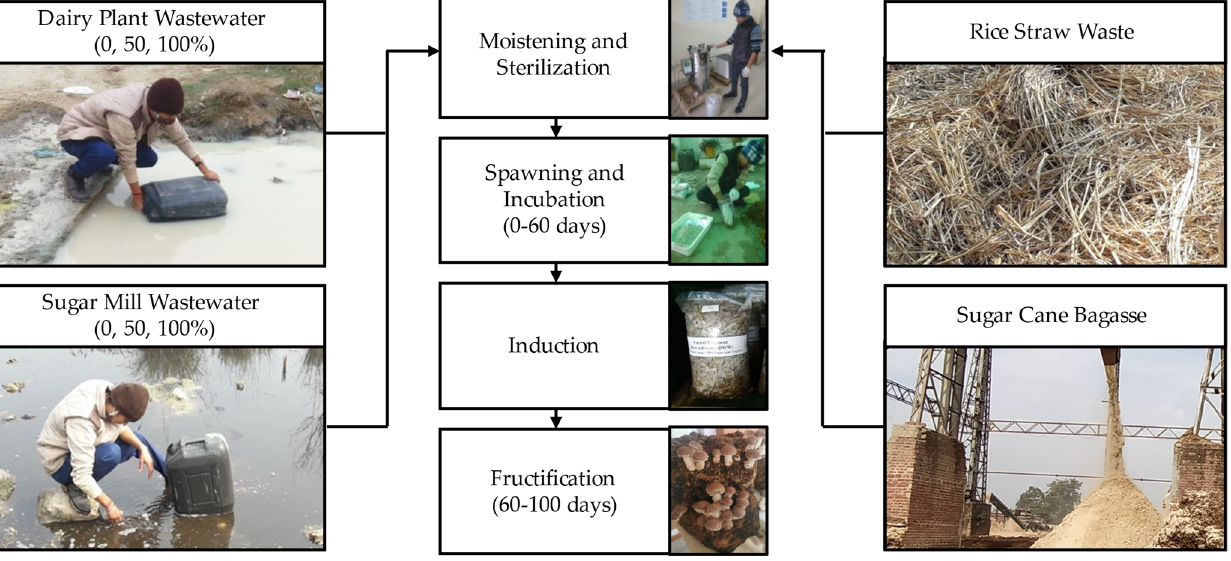
Figure 1. Experimental steps for Shiitake mushroom cultivation using agro-industrial wastes.